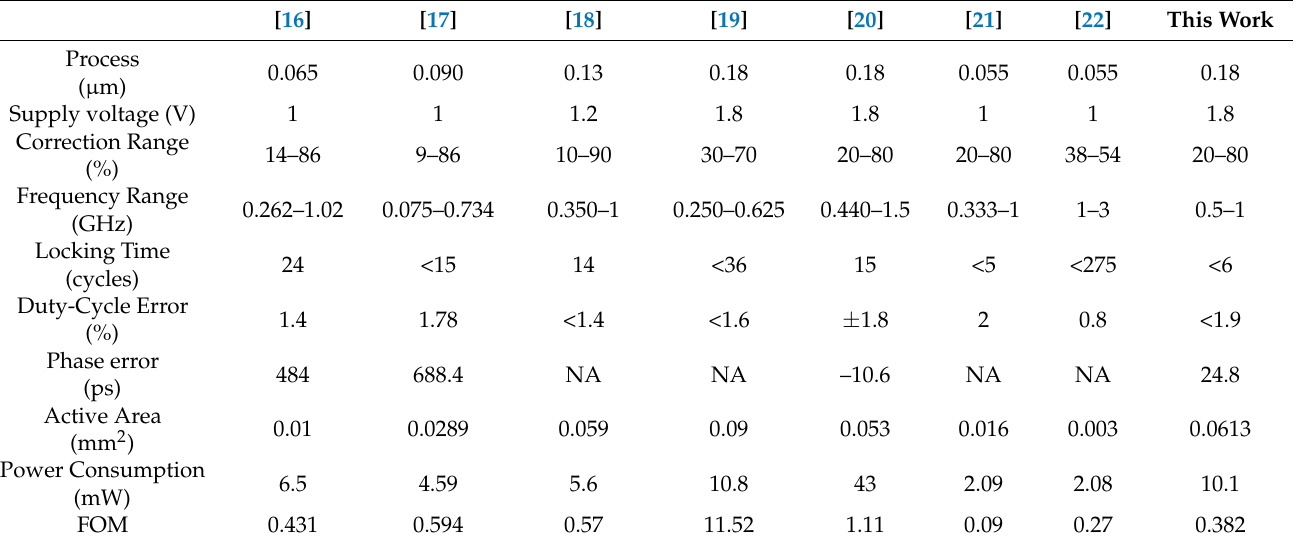
Table 1. Performance summary and